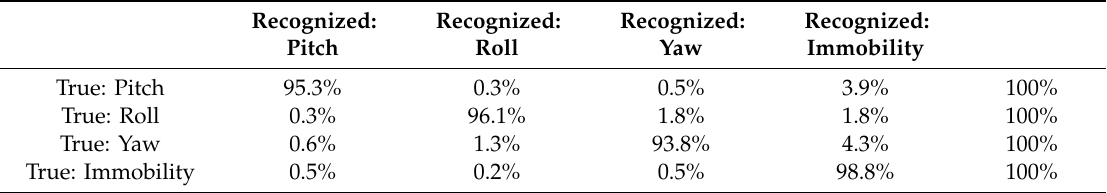
Table 5. The confusion matrix showing inter-gesture recognition errors for the SVM classifier with an RBF kernel and C = 10.0 (the classifier trained on IMU signal